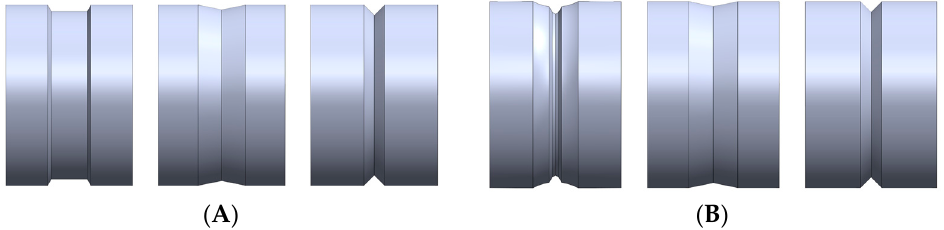
Figure 3. Bottom and top roll geometries for first 3 passes. ( A ) Bottom roll geometry. ( B ) Top roll geometry.